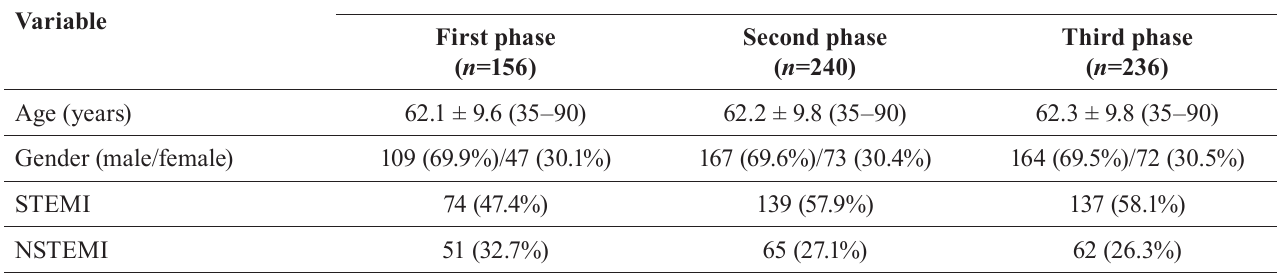
TABLE I - C haracteristics of the study population of acute coronary syndrome patients receiving statin therapy